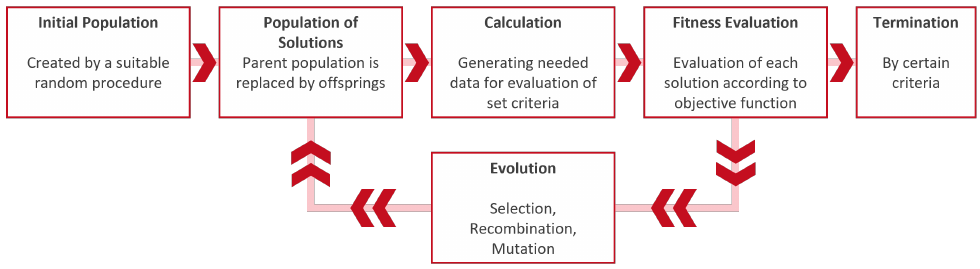
Figure 1. Principal of genetic